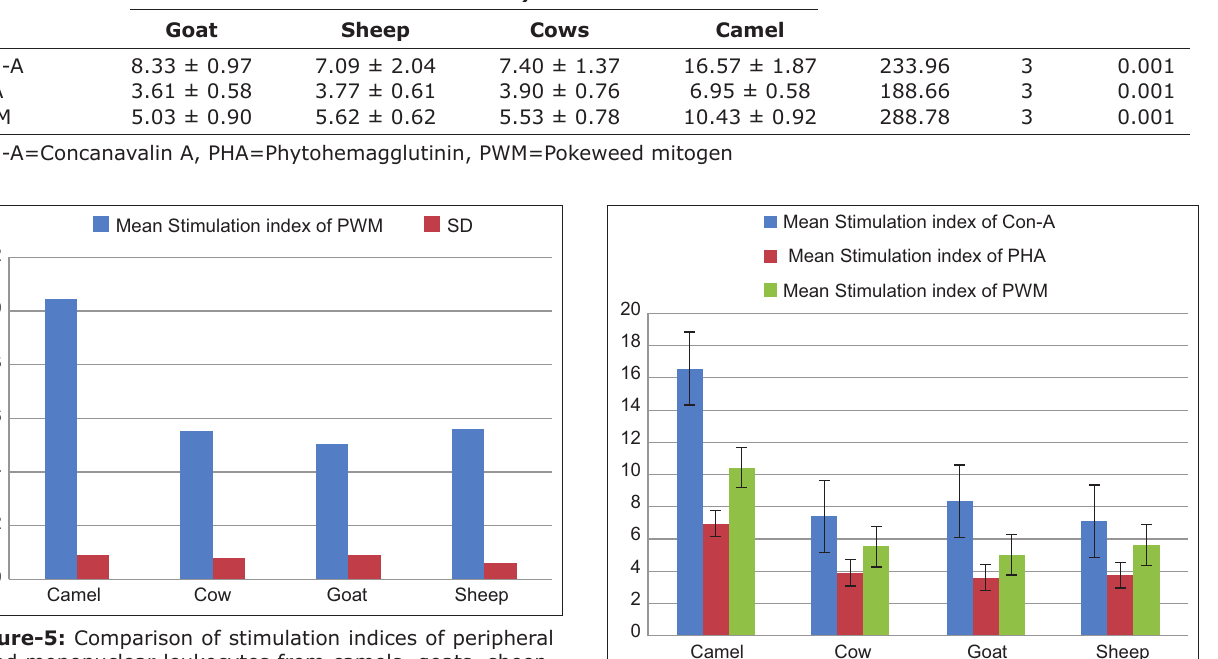
Table-4: Comparison of stimulation indices of peripheral blood mononuclear leukocytes of camels, goats, sheep, and cows stimulated with Con-A, PHA, and PWM. Variables